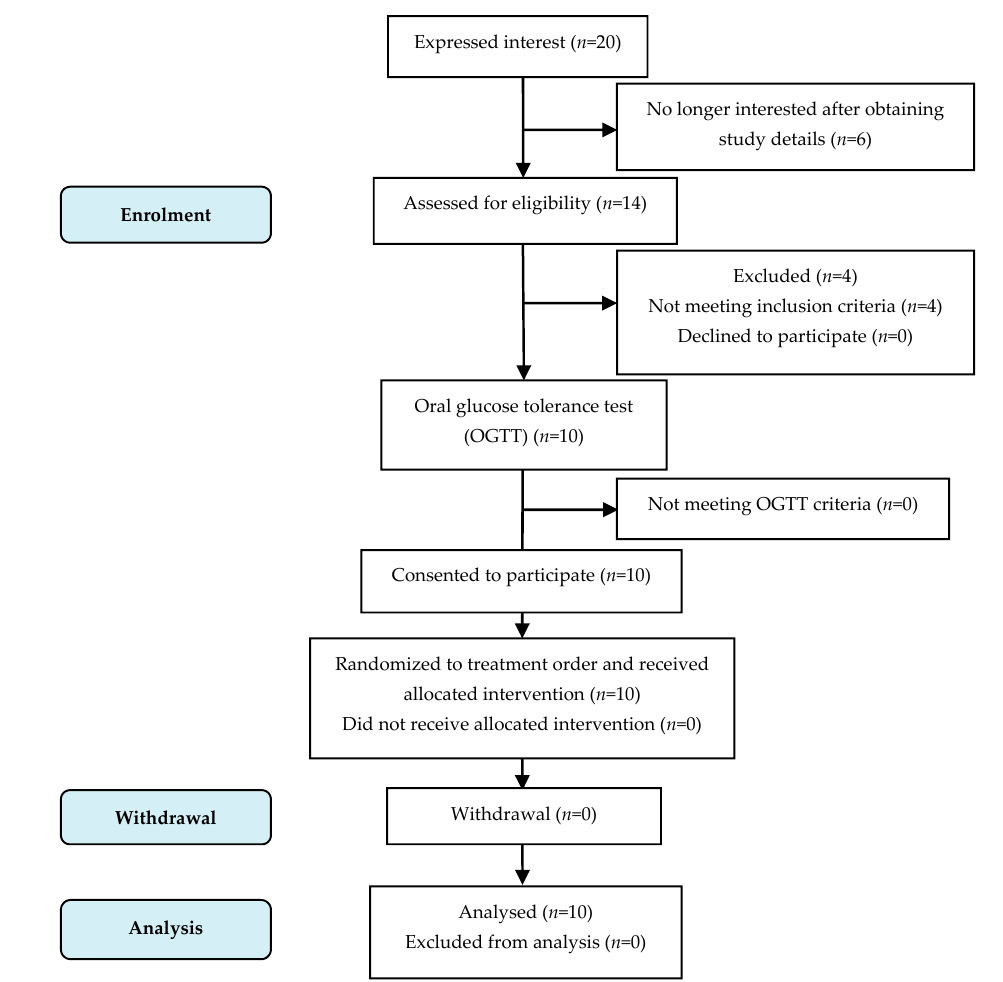
Figure 2. Consolidated standards of reporting trial (CONSORT) flow diagram of the study subjects.